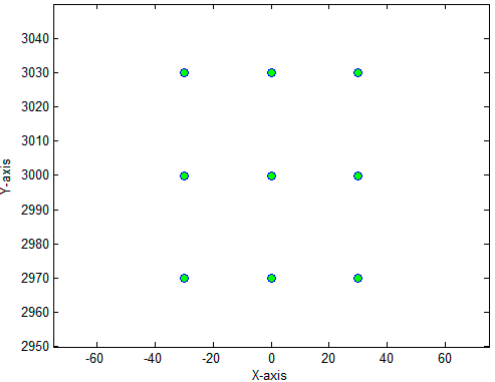
Figure 4. Simulation point targets.